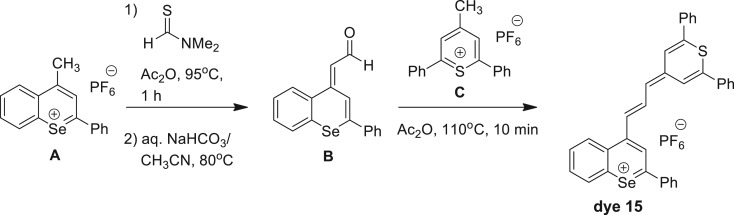
Synthesis of dye 15.